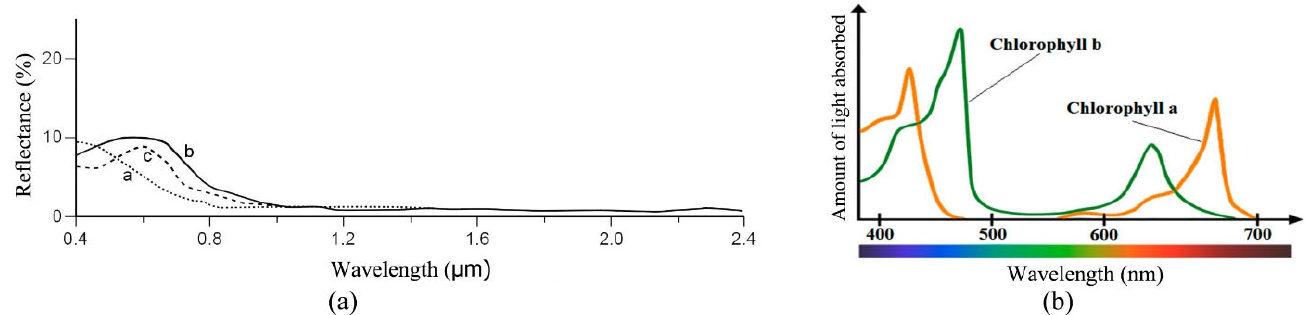
Figure 9. ( a ) Typical effects of chlorophyll and sediments on water reflectance [205]: graph a, b, and c indicate ocean water, turbid water, and water with chlorophyll respectively; ( b ) the absorption spectrum of both the Chl-a and the Chl-b pigments